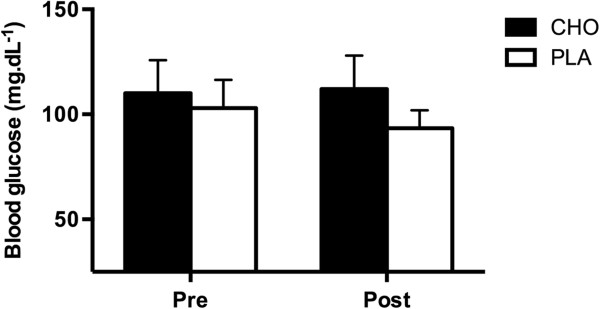
Blood glucose concentration (mean±SD) during PLA and CHO conditions.